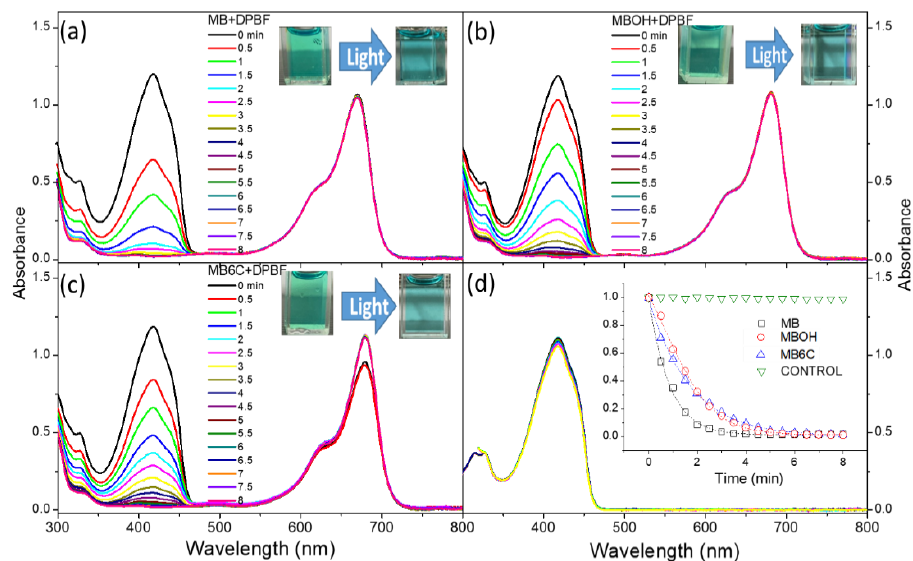
Figure 4. Absorption spectra variations of DPBF mix ( a ) MB, ( b ) MBOH, and ( c ) MB6C in DMSO under an irradiation environment, as described in the experimental section. The control experiment without adding a compound is shown in ( d ), and the insert shows the comparison of DPBF oxidation rates by singlet oxygens of the above experimental results.